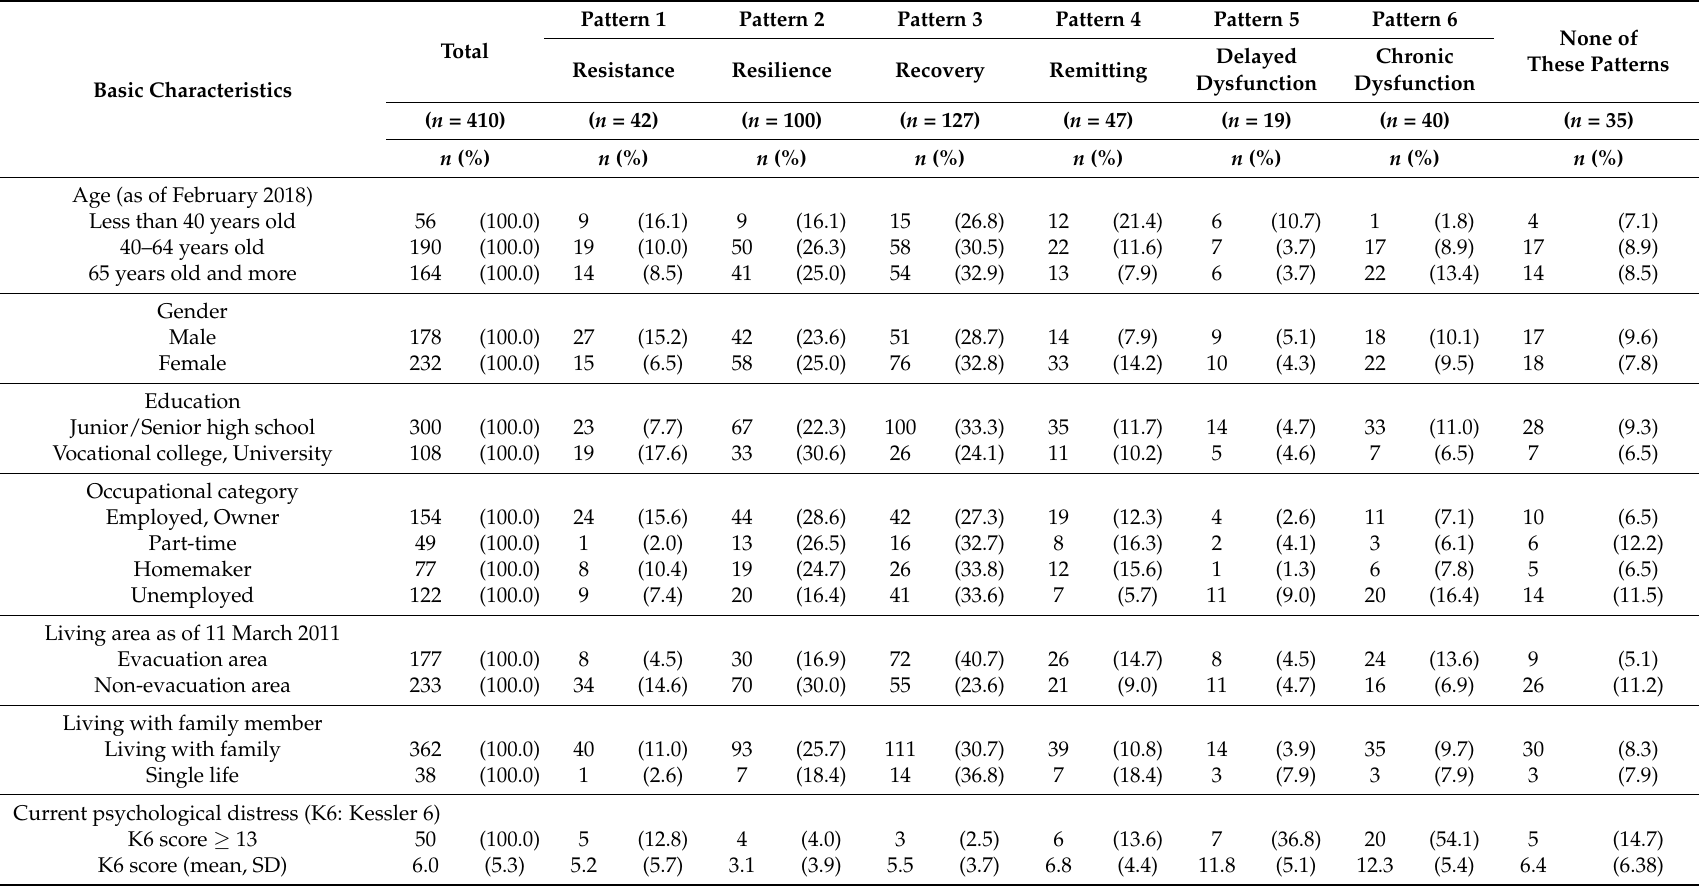
Table 1. Basic characteristics of respondents (each mental health recovery